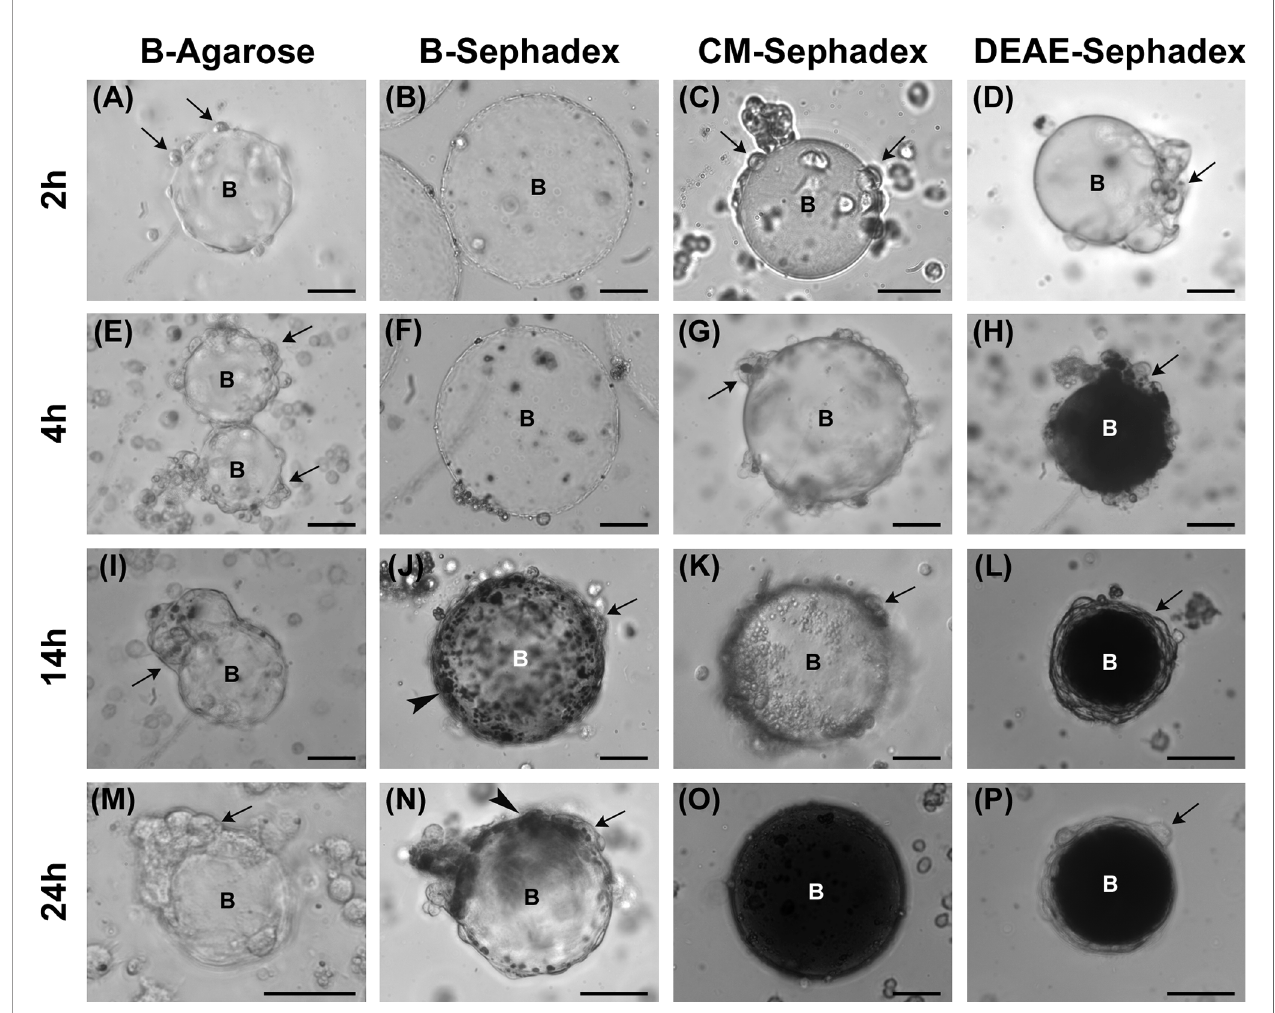
FIGURE 4 | Analysis of encapsulation. Effect of B-Agarose (A, E, I, M) , B-Sephadex (B, F, J, N) , CM-Sephadex (C, G, K, O) , and DEAE-Sephadex (D, H, L, P) beads on encapsulation and melanization. Hemolymph was analyzed 2 (A – D) , 4 (E – H) , 14 (I – L) , and 24 (M-P) hours after injecting the beads in the larvae. Arrows, adherent hemocytes; arrowheads, melanin deposition; B, beads. Bars: 40